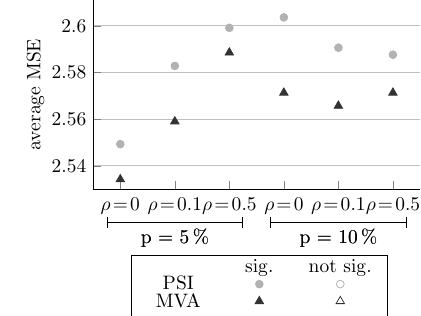
Figure 5. Comparing the MSE of the methods extending the normalized AIC and multiple imputation (MI), averaged over 100 simulations, and the significance of the differences.